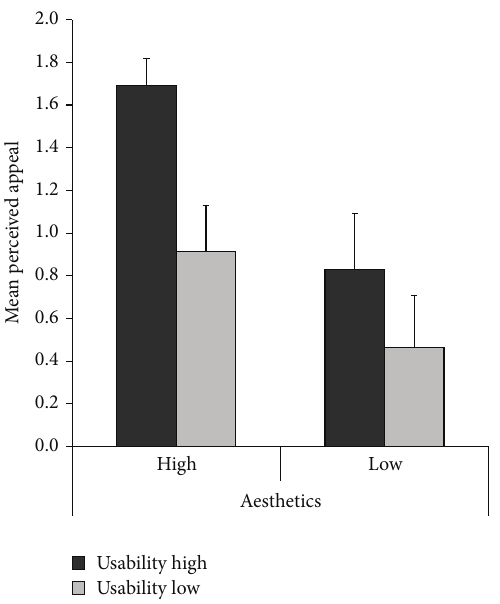
Figure 7: Mean rating of HQI, depending on the mobile’s manip- ulated usability (high versus low) and the manipulated aesthetics (high versus low). Note that the scale ranges from − 3 to +3. Vertical lines indicate the standard error of the mean.